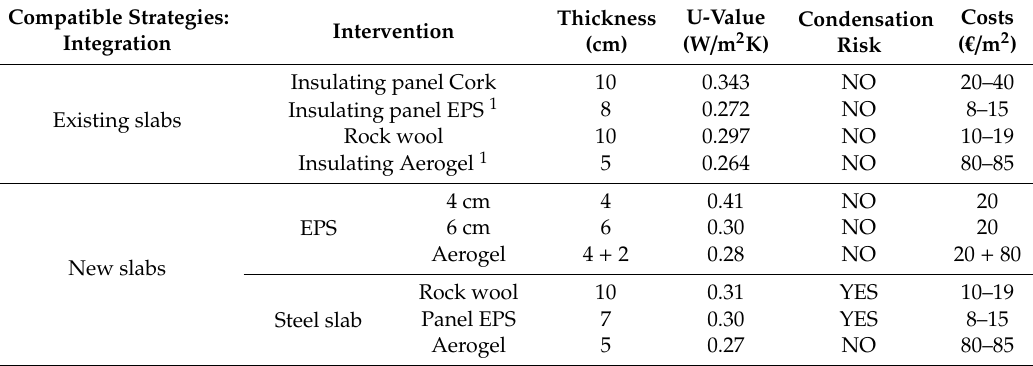
Table 4. Summary of the energy interventions studied for the